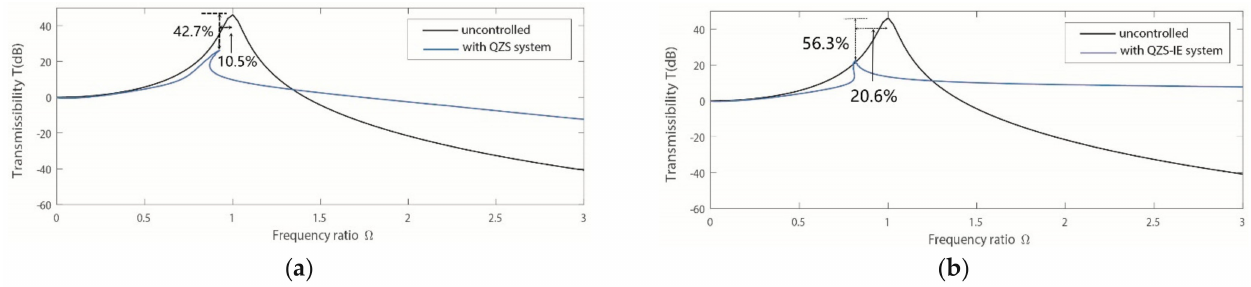
Figure 11. The vibration suppression effects of the seat suspension system ( u 0 = 1.0): ( a ) The displacement transmissibility of the QZS system without inerter elements; ( b ) the displacement transmissibility of the QZS-IE